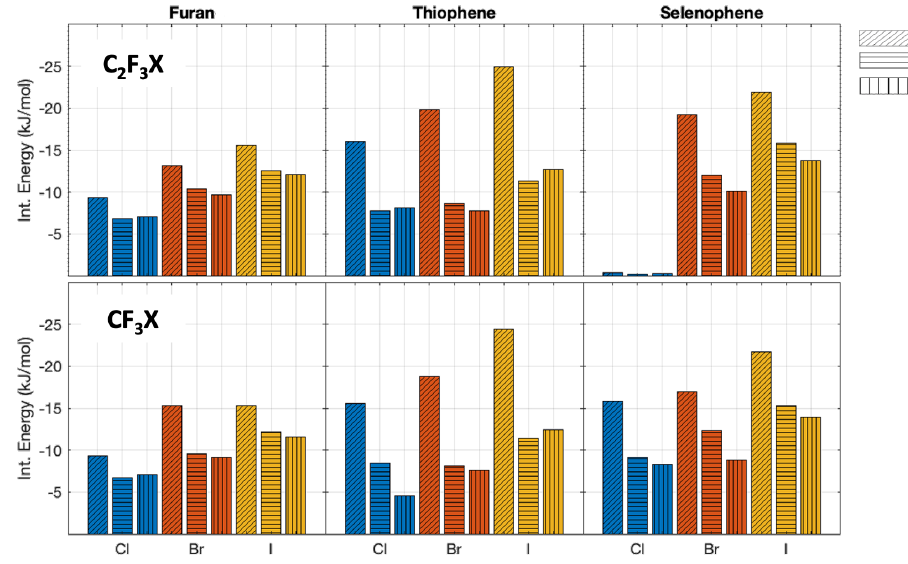
Figure 2. PBE0 − dDsC We changed it interaction energies (without zero-point vibrational energy correction) with different basis sets for the complexes oriented in parallel. The different halogens are depicted with the following colormap: chlorine blue, bromine red, and iodine yellow. The DZP basis set is represented with slanted lines, the TZ2P with horizontal lines, and QZ4P with vertical lines.